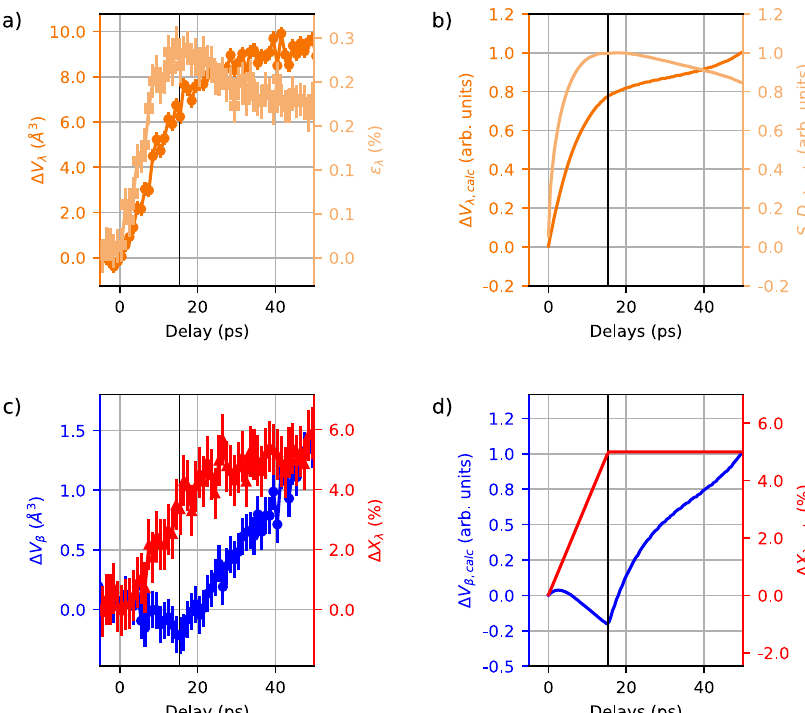
Fig. 4 Evolution of long range order and phase change on the acoustic time scales. a , c Parameters extracted from Rietveld re fi nement of the XRD data. a Temporal evolution of the λ - phase unit cell volume ( Δ V λ , dark orange, fi lled circles) and microstrain parameter ϕ λ (light orange, fi lled squares). c Temporal evolution of the β - phase unit cell volume ( Δ V β , blue) and λ - phase fraction ( Δ X λ , red). Relative changes normalized to the change at 50ps and errors estimated as described in the Methods section. b , d Simulation with the Thomsen model 11 of the parameters shown in ( a , c ). All details are given in the SI. b λ - crystallites. Calculation of the expected evolution of the volume change ( Δ V λ , calc, dark orange) and microstrain (S. D. λ , calc, light orange) following ultrafast excitation. Parameters of the model are taken as follows: laser penetration depth of χ L = 65nm, sound velocity of v s = 6.5×10 3 ms − 1 ; curves normalized to the value at t = 50ps. d β -crystallites. Calculation of the expected evolution of the volume change ( Δ V λ - phase fraction ( Δ X β ,calc , blue) and λ ,calc, red) following ultrafast excitation. The corresponding acoustic front propagation time corresponding to z S = 100nm, ϕ PF = z S / v s ) is shown with solid black lines in ( a , b , c , d